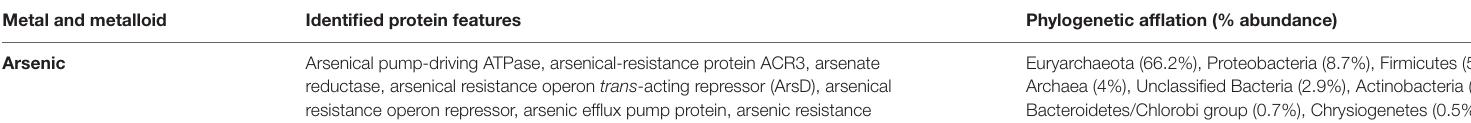
TABLE 4 | Metagenomic features associated with metal and metalloids stress response physiology in Sambhar Salt Lake microbiome. Metal and metalloid Identified protein features Phylogenetic afflation (%